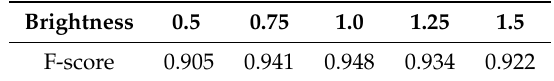
Table 6. Detection performance after changing the image